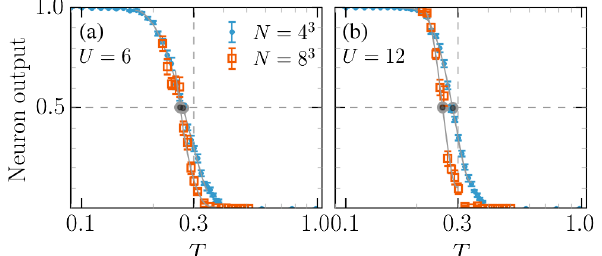
FIG. 3. Average output of the neuron that is trained to be activated (return 1) in the ordered phase as a function of temperature at half filling. The network is maximally confused (average is 0.5) at the transition temperatures. We use 90 000 configurations for N ¼ 4 3 and 10 000 configurations for N ¼ 8 3 . The grey solid lines are fits to data in the ranges shown. The vertical dashed lines indicate the estimates for T N in the thermodynamic limit (about 0.30 for both U values) from other studies (see caption of Fig.